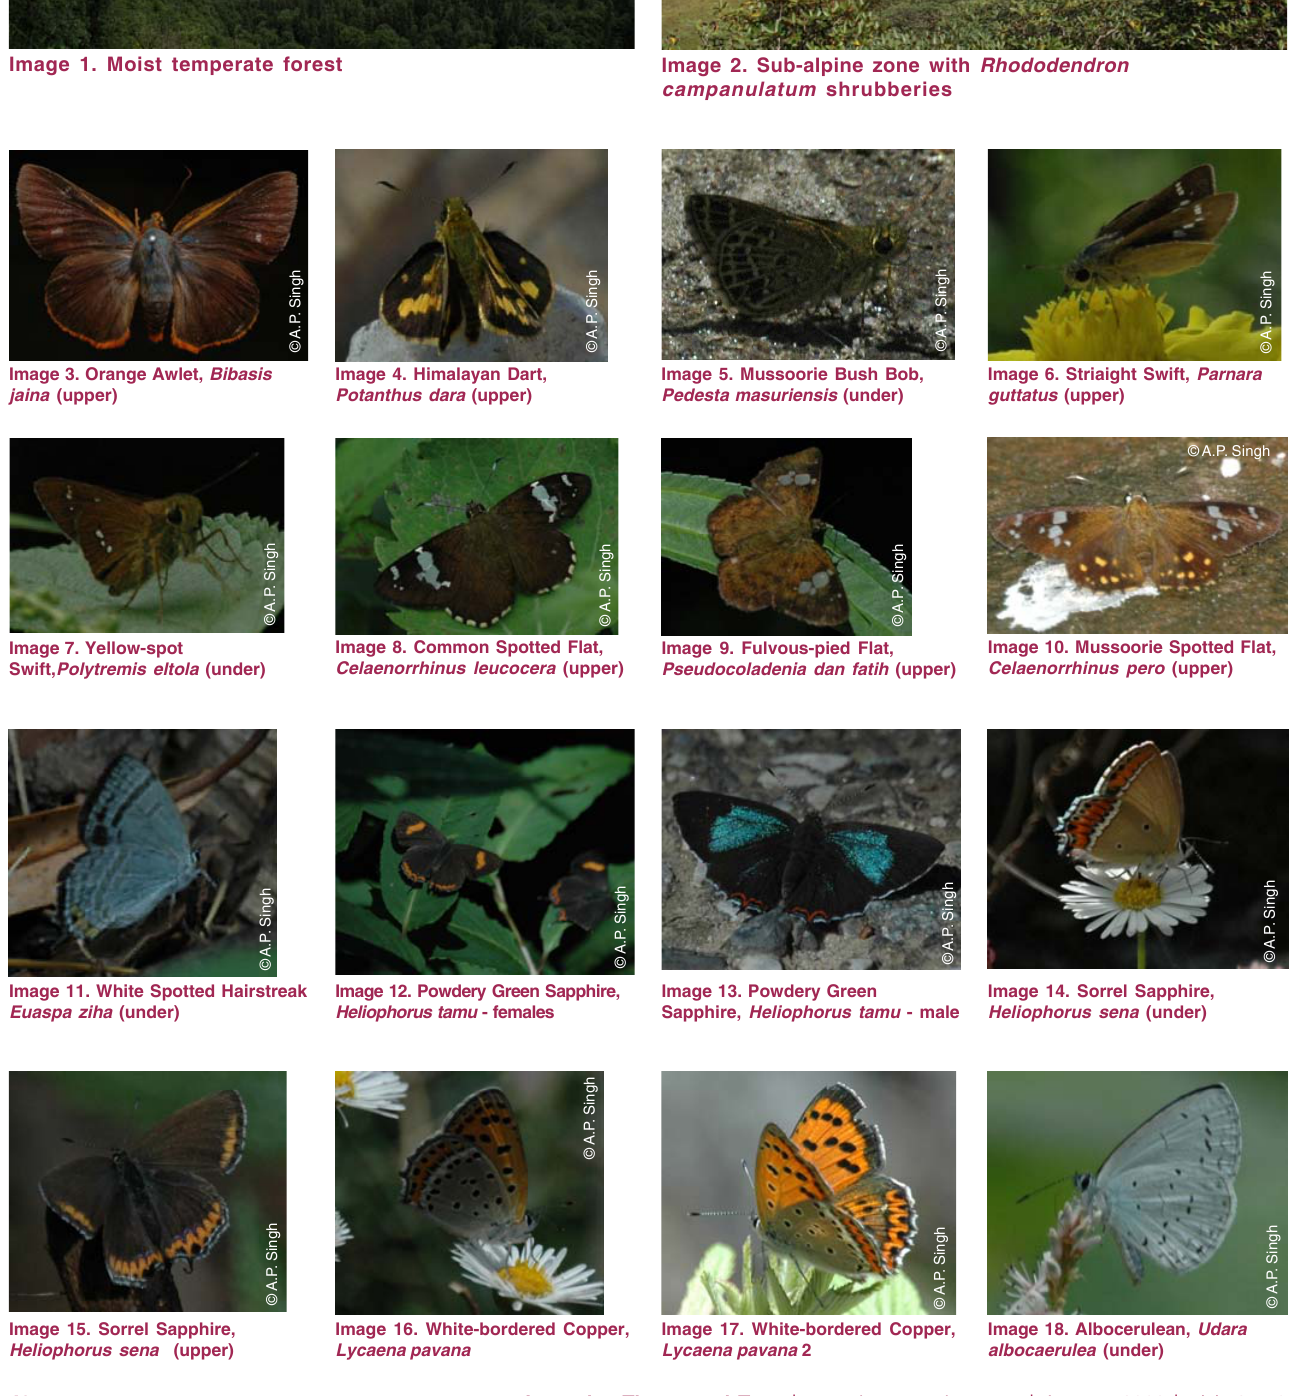
Image 17. White-bordered Copper, Lycaena pavana 2